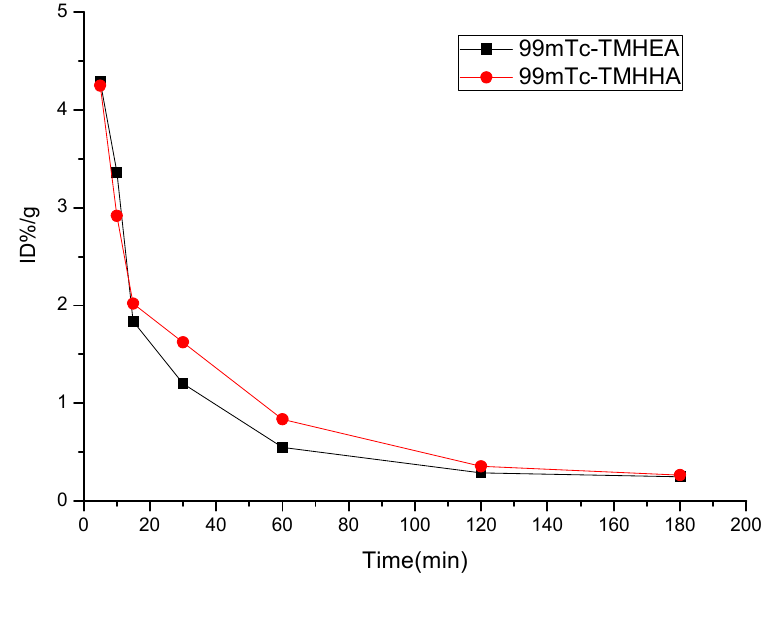
Figure 3. Pharmacokinetic curves in the mice for 99m Tc-TMHEA and 99m